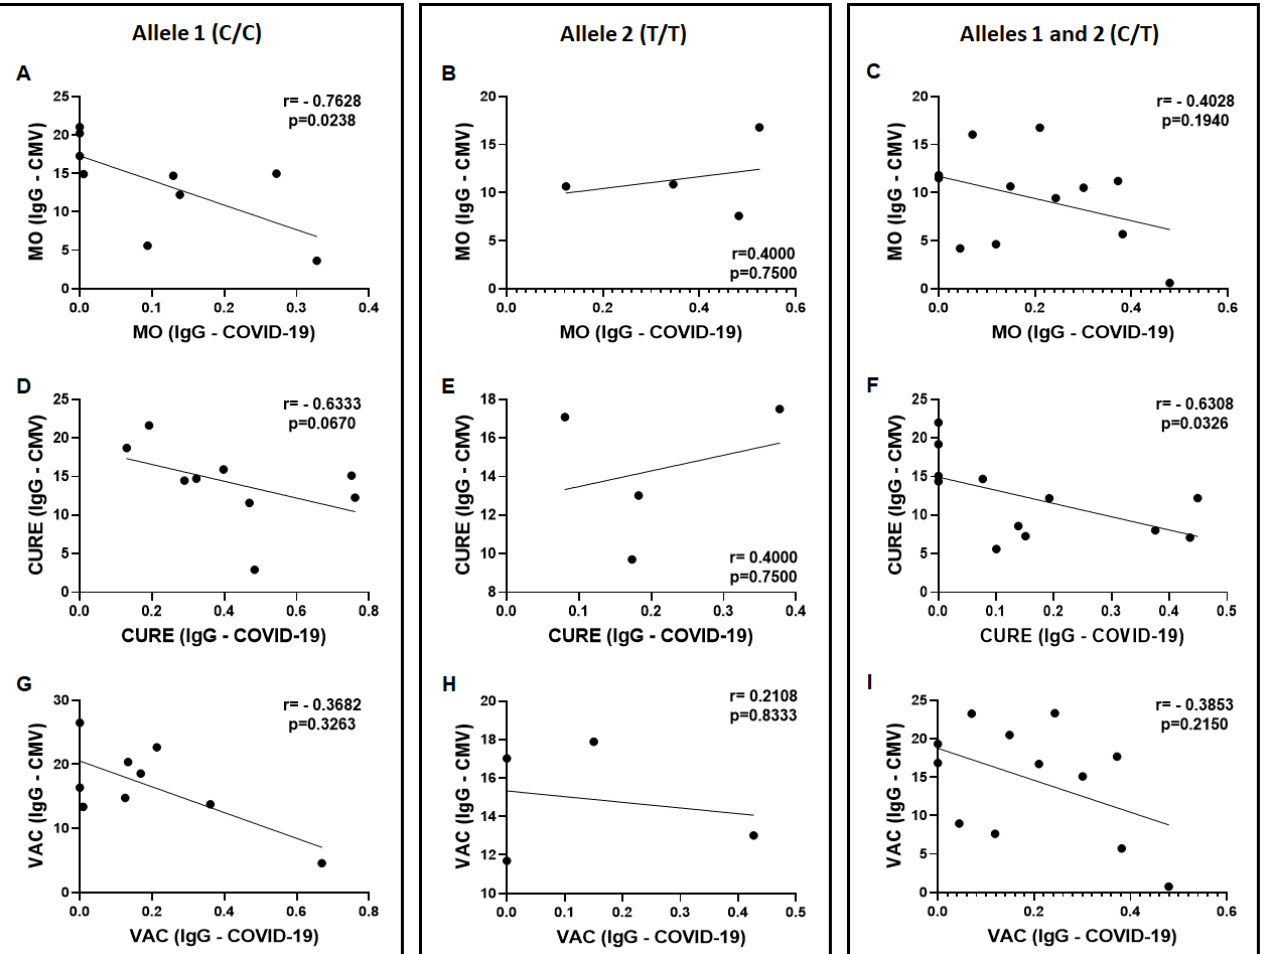
Figure 6 . Spearman coefficient correlation analysis between total serum levels of CMV-specific IgG (IU/mL) and COVID-19 IgG (O.D. 450 nm) in the volunteers grouped in accordance with the polymorphism in the IFN-lambda gene [allele 1 (C/C), allele 2 (T/T), and alleles 1 and 2 (heterozygous, C/T)], on three different occasions: during the micro-outbreak of SARS-CoV-2 infection (MO — A , B , and C , respectively), 6 – 8 months after this infection (CURE — D , E , and F , respectively), and 30 days after administration of the second dose of ChadOx-1 vaccine (VAC — G , H , and I , respectively).